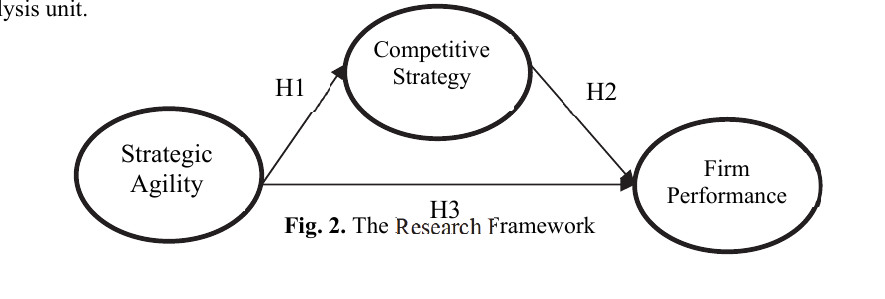
Fig. 2. The Research